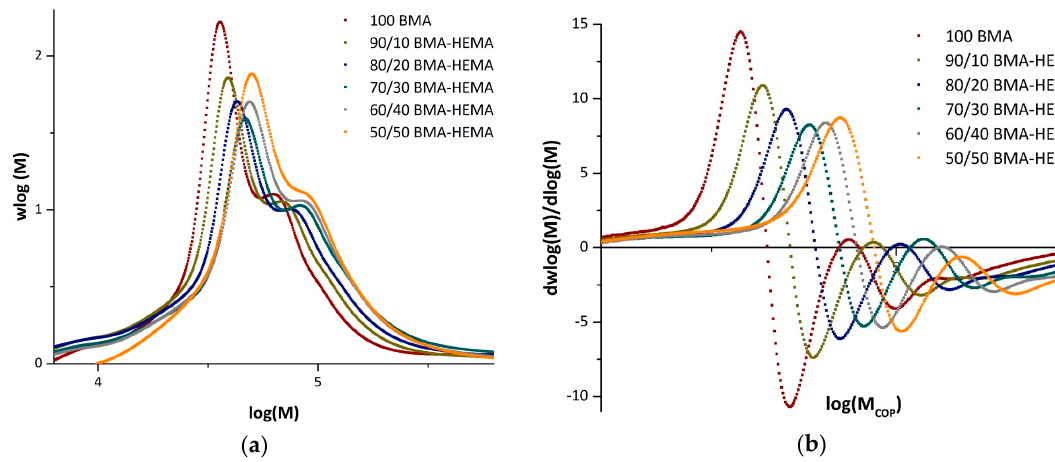
Figure 4. ( a ) Size exclusion chromatography (SEC)-measured molecular weight distributions and ( b ) resultant first derivative curves of BMA/HEMA copolymers generated by pulsed laser polymerization (PLP) of bulk BMA/HEMA mixtures of varying monomer composition. PLP experiments conducted at 80 °C with a pulse repetition rate of 35 Hz using 5 mmol/L 2,2-dimethoxy- 2-phenylacetophenone